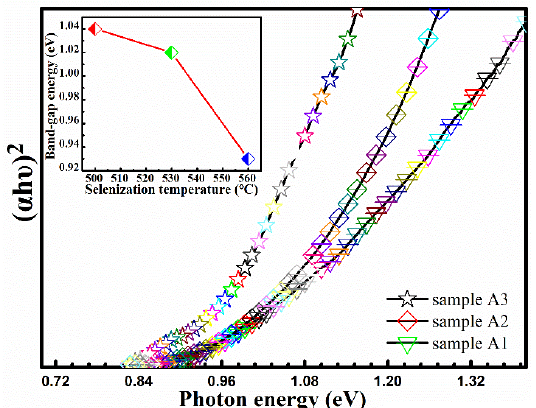
Figure 6. The plot of ( αhυ ) 2 vs. hυ for the absorption spectra. Inset: Bandgap variation as a function of the selenization temperature.